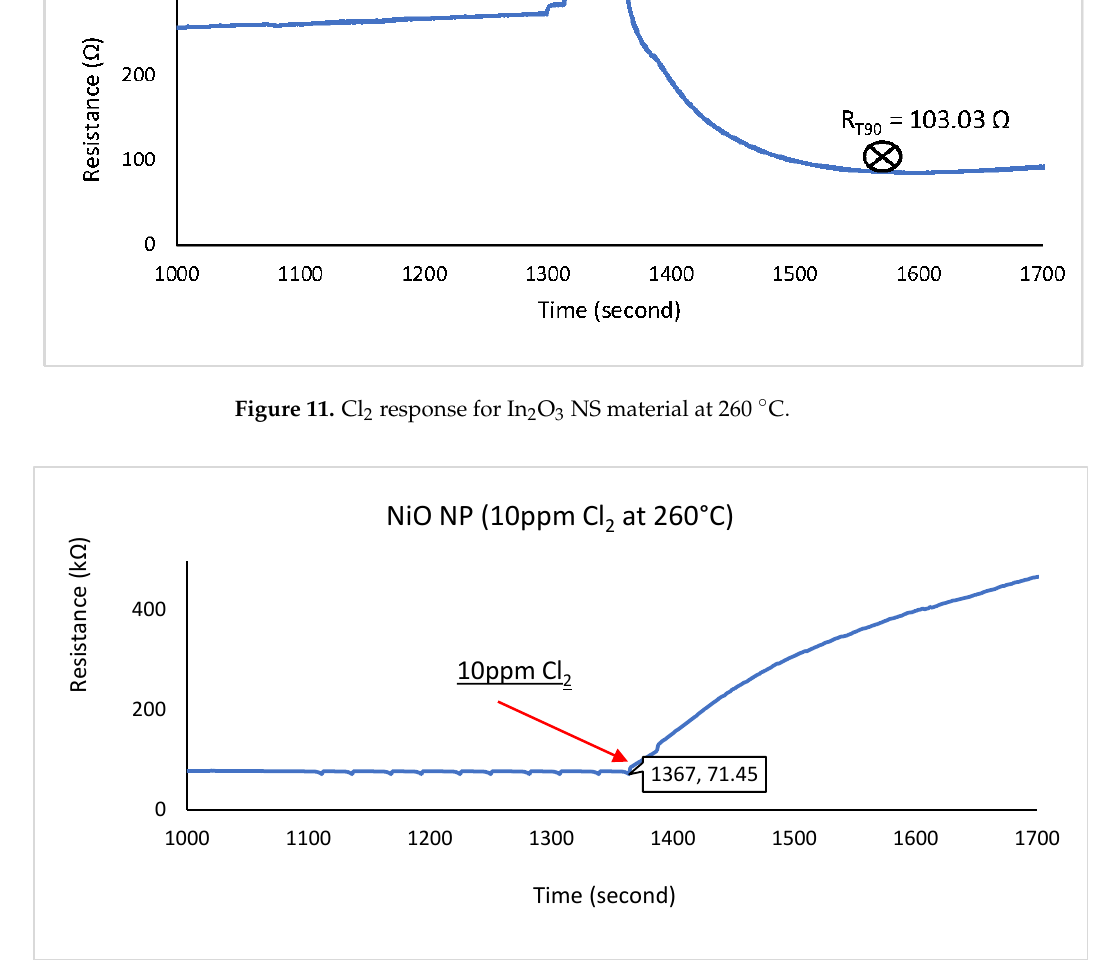
Figure 12. Cl 2 response for NiO NP the material at 260 °C.